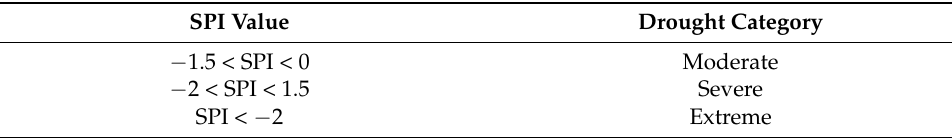
Table 1. Drought categories defined based on the SPI